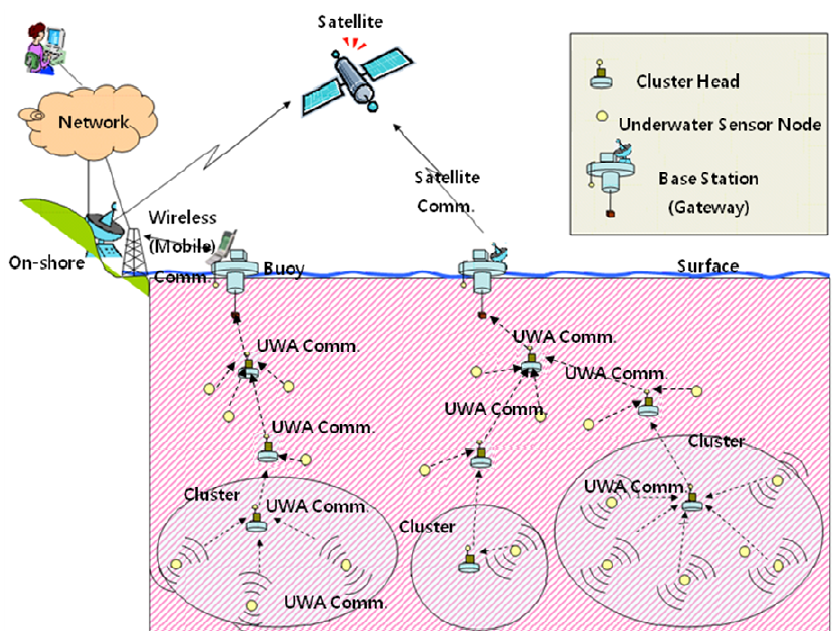
Figure 1. Cluster-based underwater acoustic sensor network